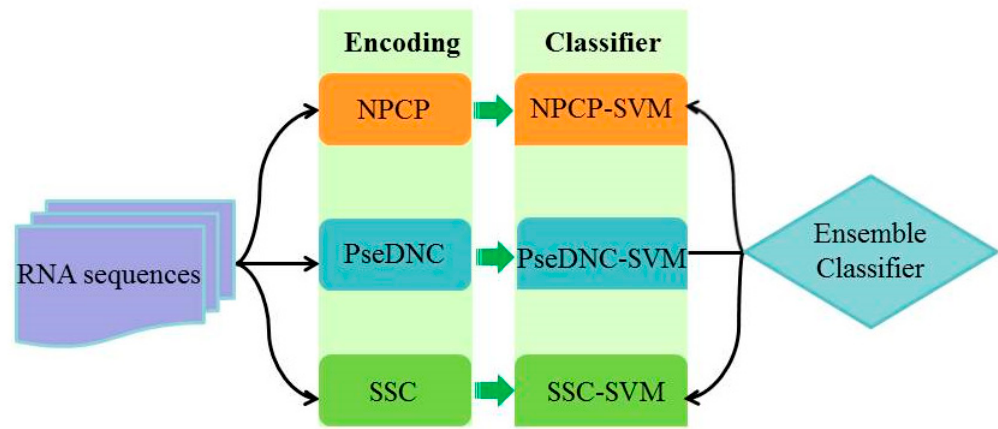
Figure 1. The flaw chart of the ensemble classifiers. NPCP-SVM stands for nucleotide-physicochemical- property-based predictor; PseDNC-SVM stands for pseudo-dinucleotide-composition-based predictor; Figure 1 The flaw chart of the ensemble classifiers. NPCP-SVM stands for nucleotide- SSC-SVM stands for secondary-structure-based physicochemical-property-based predictor; PseDNC-SVM stands for pseudo-dinucleotide- composition-based predictor; SSC-SVM stands for secondary-structure-based predictor.